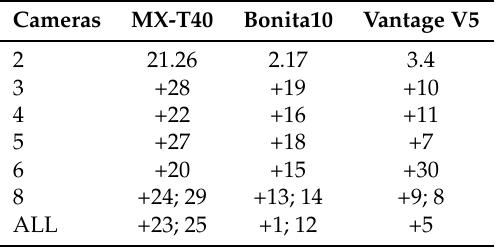
Table 3. Number and (incrementally) IDs of cameras used for 3D marker reconstruction.